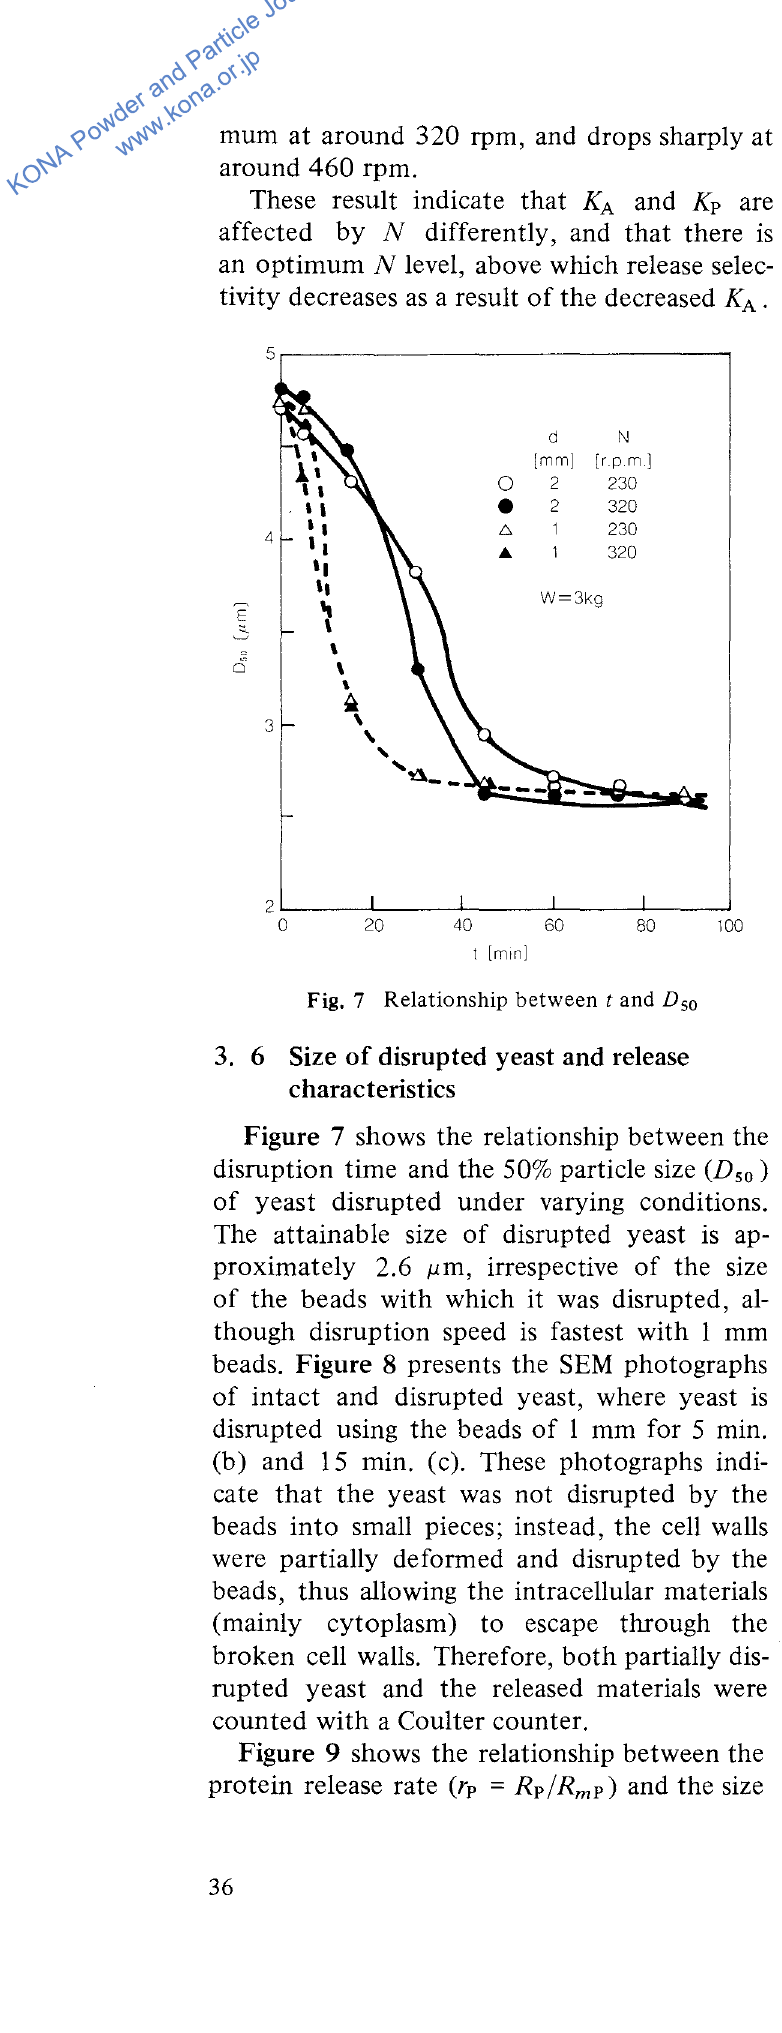
Fig. 7 Relationship between t and D 50